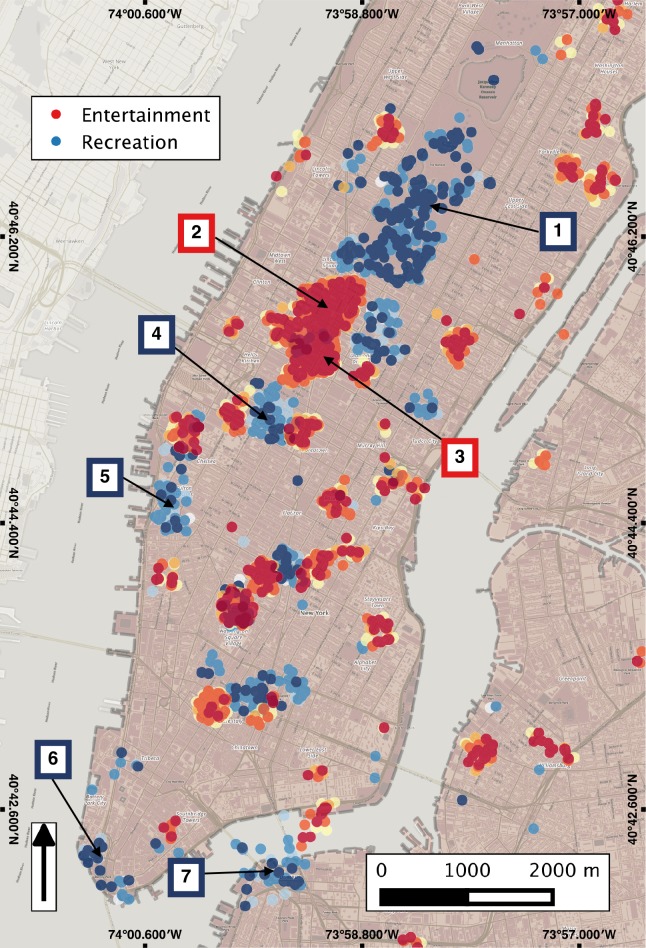
Statistically significant clusters of recreation and entertainment categories concentrated over Manhattan, NYC.For reference, the following sample places are labelled in the map with colour coded borders based on the legend features: (1) Central Park, (2) Broadway, (3) Times Square, (4) Madison Square Garden, (5) High Line Park, (6) Battery Park, and (7) Brooklyn Bridge Park.